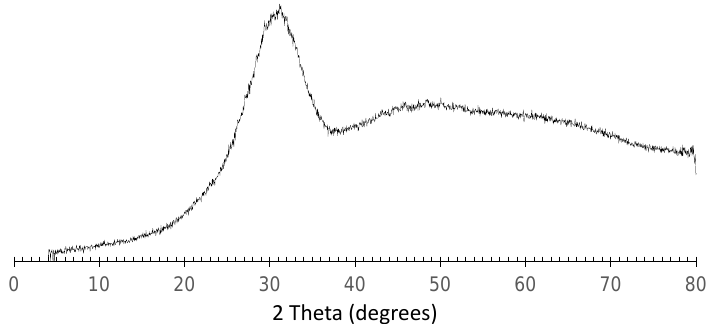
0 Figure 2. XRD pattern of GGBFS. Figure 2. XRD pattern of